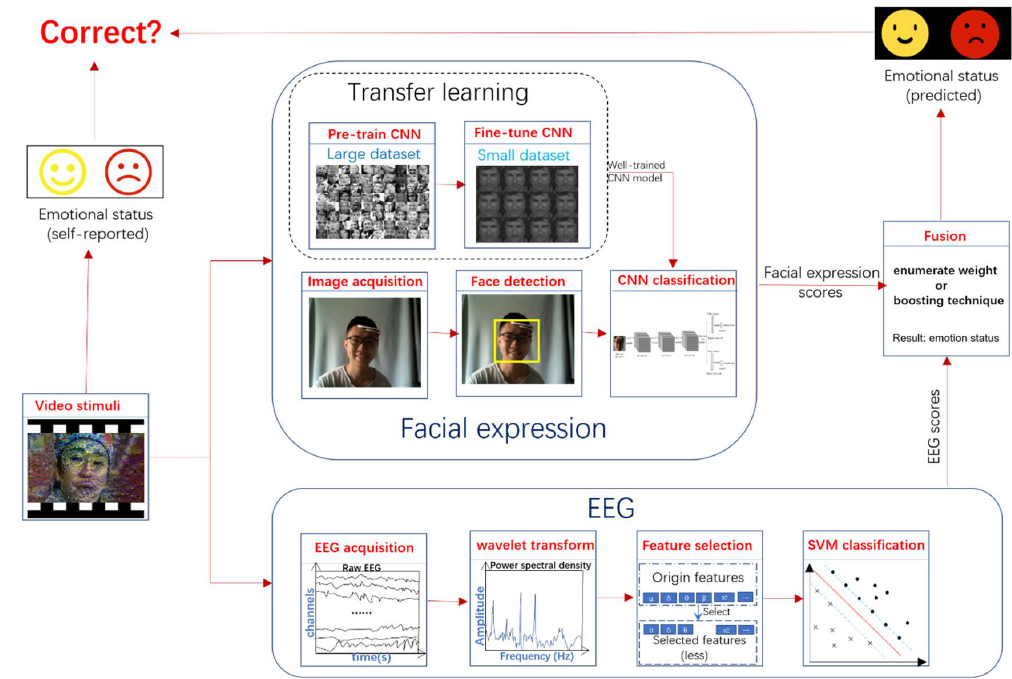
Figure 1. An overview of the workflow in this work .